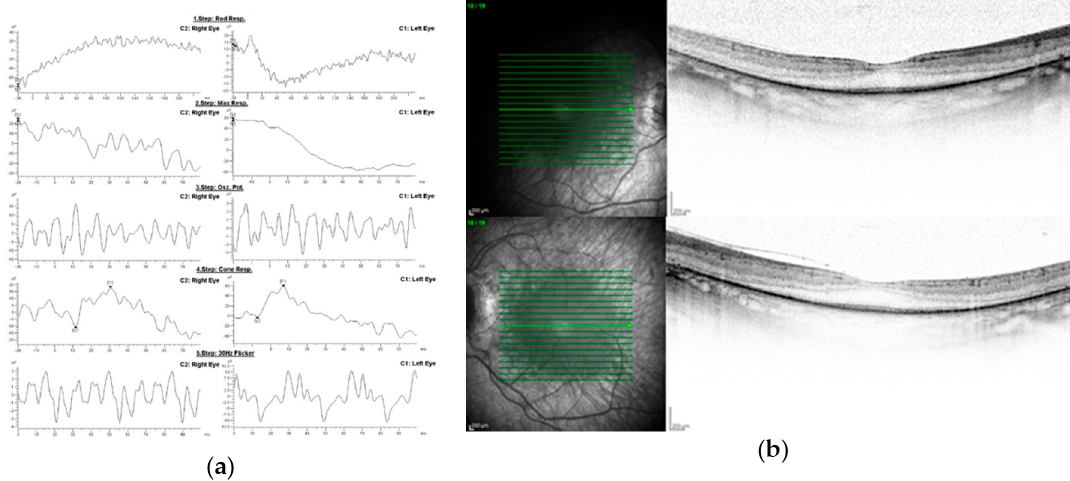
Figure 3. ( a ) Electroretinogram of the patient. ( b ) Macular optical coherence tomography and infrared image.